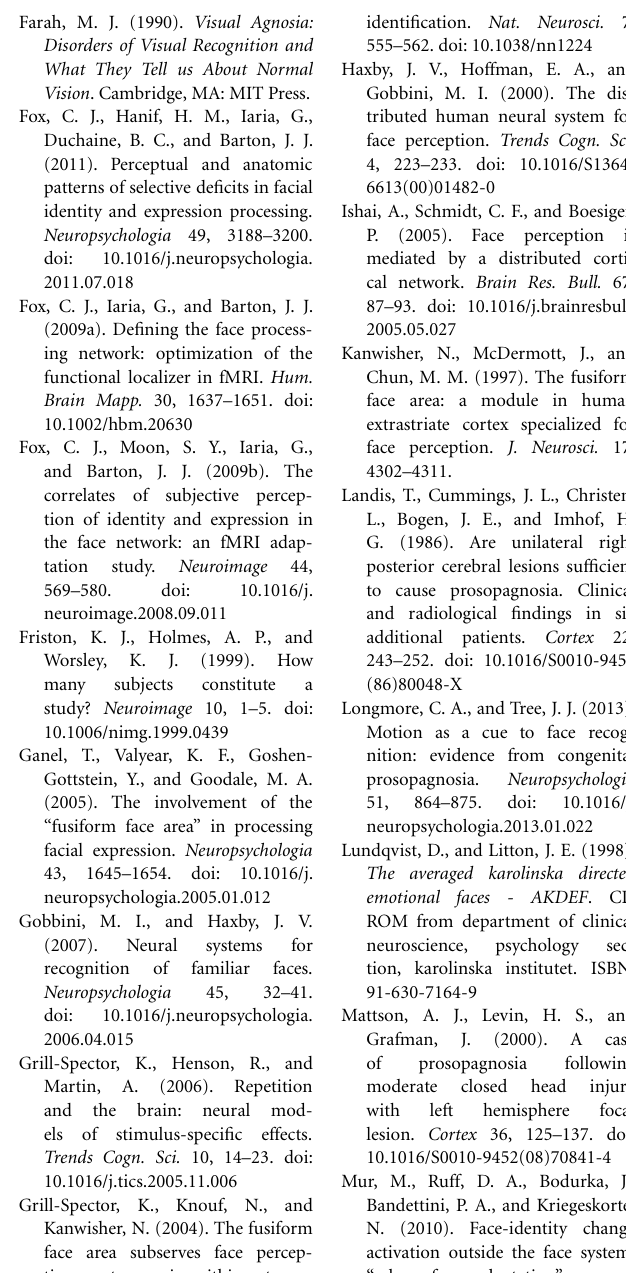
Supplemental Figure 1 | (A) Control data for the different-identity/ same-expression > same-identity/same-expression contrast. A significant release from adaptation (*) for identity changes was seen within the right FFA of C01 and C03, and within the left OFA of C03. A trend in the same direction (#) was observed in the right OFA of C03. (B) No significant release from adaptation was observed for changes in expression, following the same-identity/different-expression > same-identity/same- expression contrast. When compared to the data from the patient population we again see a release from adaptation to identity changes in the right FFA (2/3 controls) but there is no evidence of sensitivity to facial expression with this experimental